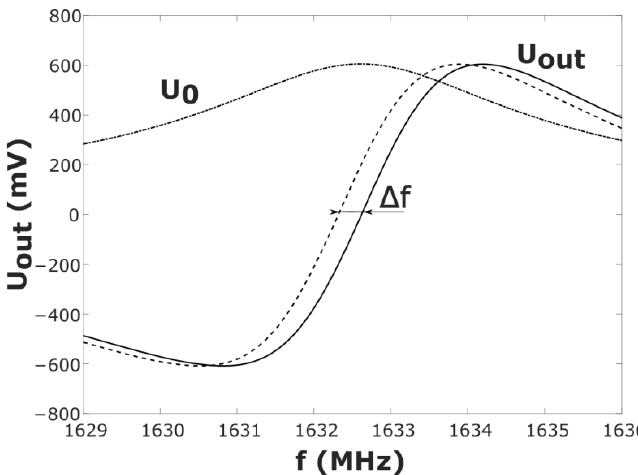
Figure 3. Experimental characteristics of the humidity sensor. 𝑈 0 (𝑓) is the amplitudefrequency dependence of the signal transmitted through the cavity, and 𝑈 𝑜𝑢𝑡 (𝑓) is the frequency dependence of the signal output from the measuring system for a sensor with and without the gas (the dashed line and the solid line, respectively).